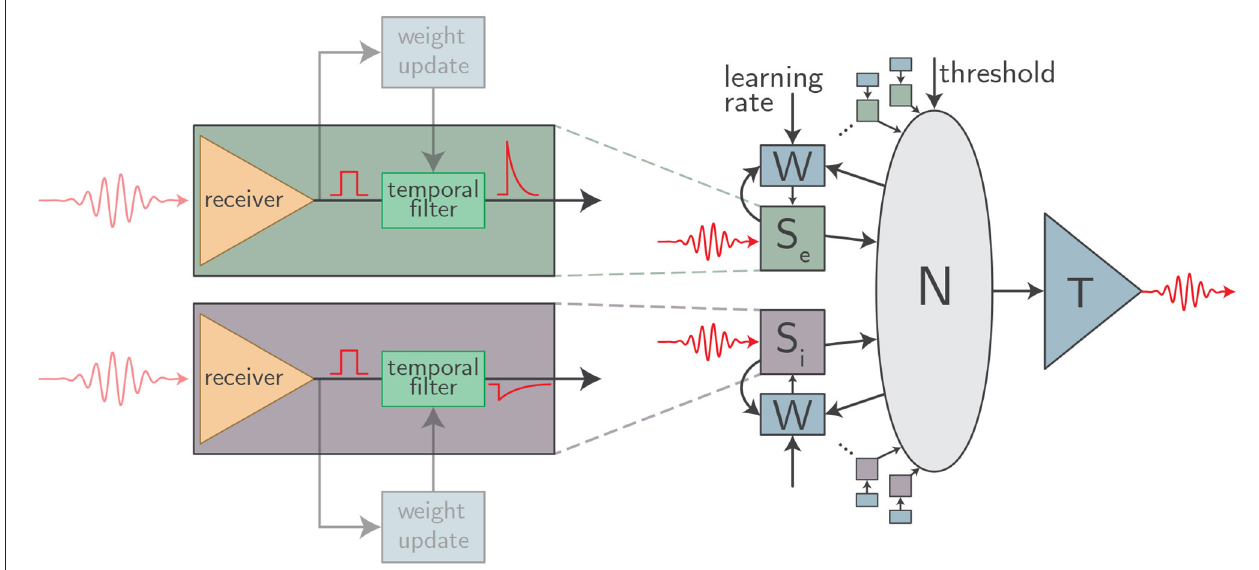
FIGURE 1 | An abstract schematic of the class of optoelectronic neurons meeting our three criteria. Each synapse ( S e and S i for expiatory and inhibitory synapses, respectively) is implemented with a physical circuit block containing a detector and a temporal filter. The detector produces an all-or-nothing electrical pulse upon receipt of an optical spike which is then processed by the filter. The parameters of the filter (time constant, weight, etc.) can be set individually for each synapse. A local weight update circuit (W) implements plasticity mechanisms at each synapse. Synaptic outputs are integrated in the soma (N) which drives an optical transmitter to downstream connections upon reaching threshold.